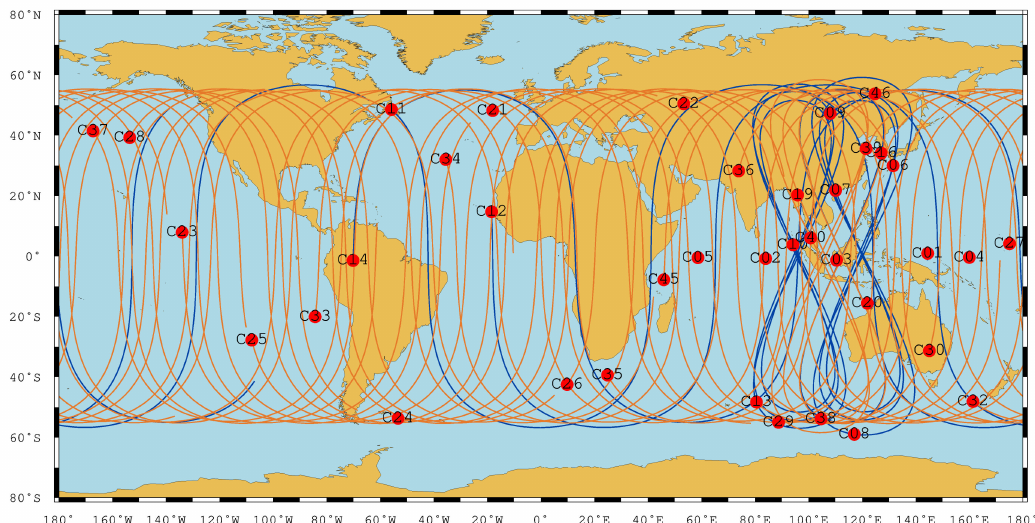
Figure 1. Ground tracks of the BeiDou navigation satellite system (BDS) at day of year (DOY) 110, 2020. Blue and orange for BDS-2 and BDS-3,